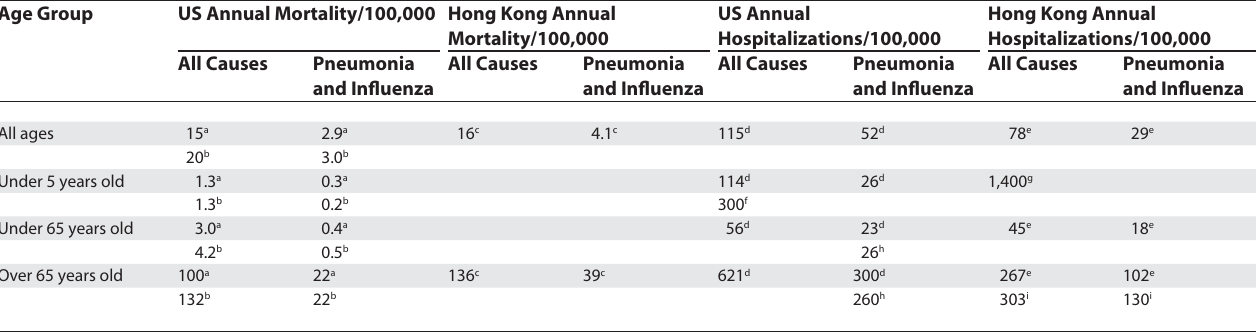
Table 1. Comparison of the Average Annual Burden of Infl uenza on Hospitalization and Death in Recent Years in Hong Kong and the